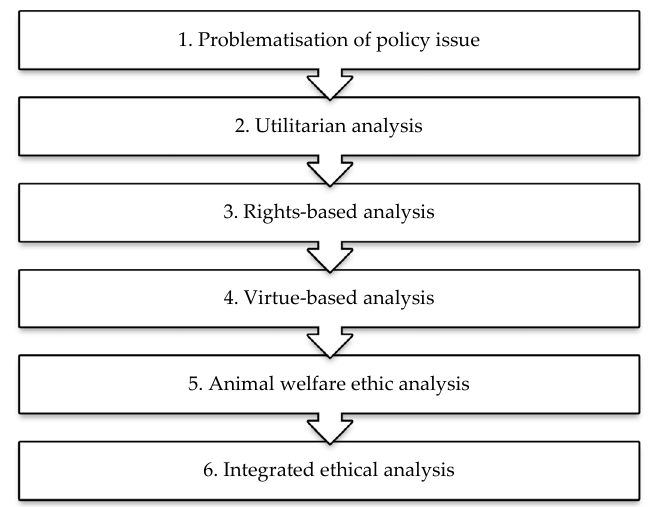
Figure 1. Six-stage process for ethical appraisal of policy options.